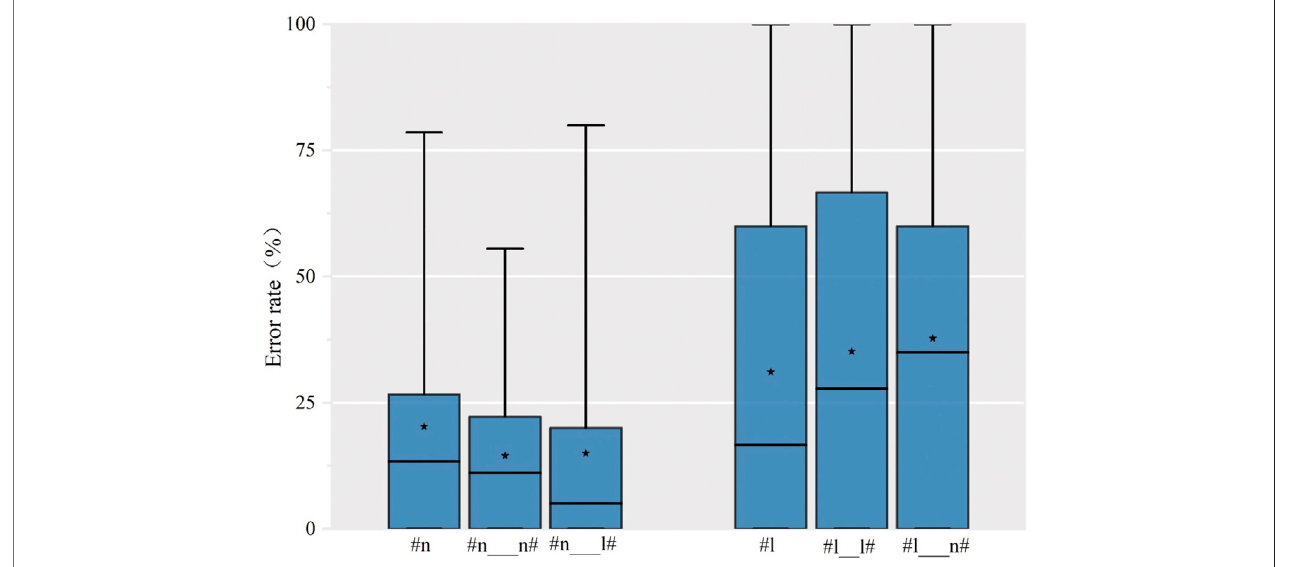
FIGURE 8 | Error rate of production for the syllable initial /n/ and /l/ in English words by subjects ’ variety.